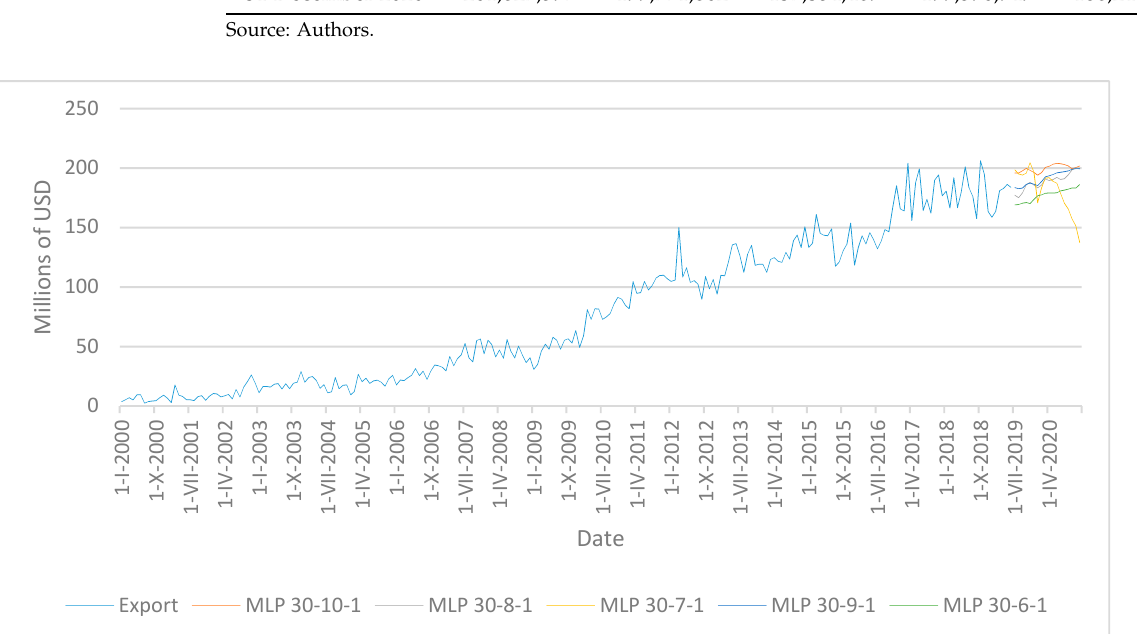
Figure 7 . Time series and predicted development of exports according to retained networks (Experiment 3) . Source: Au- thors.